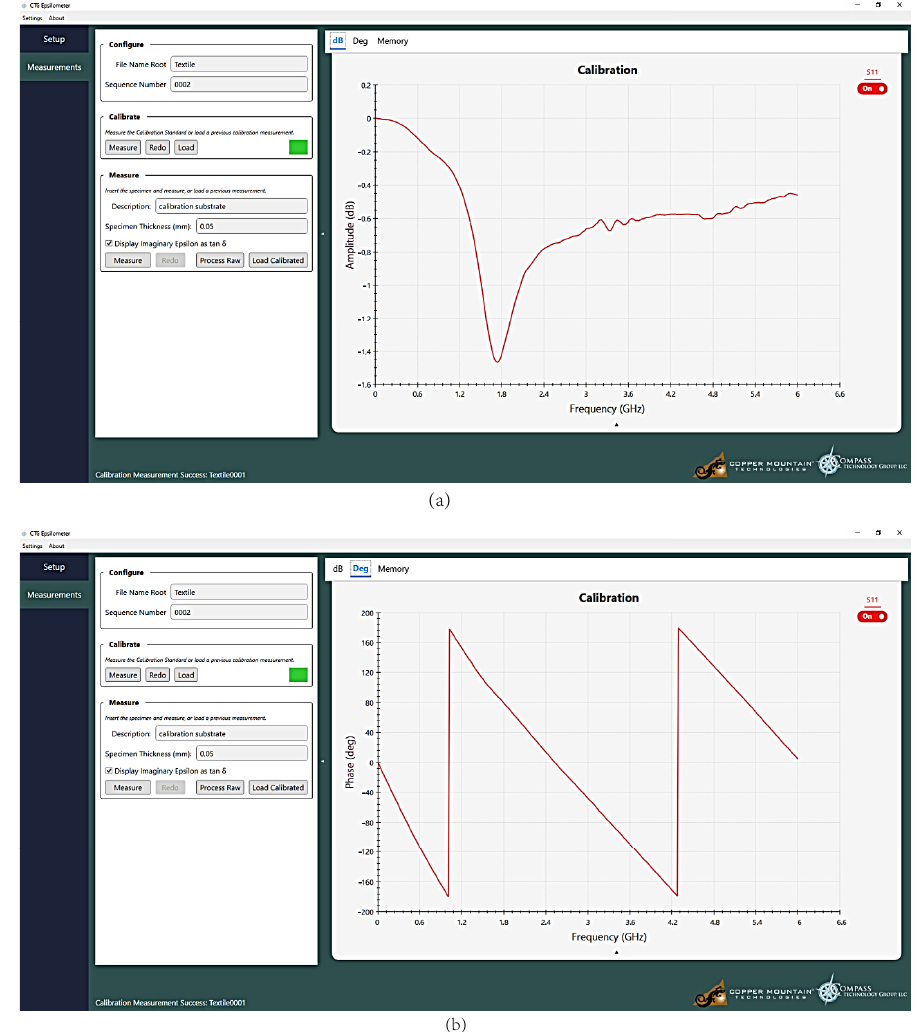
Figure 7. Results of apparatus calibration: ( a ) amplitude characteristic; ( b ) phase